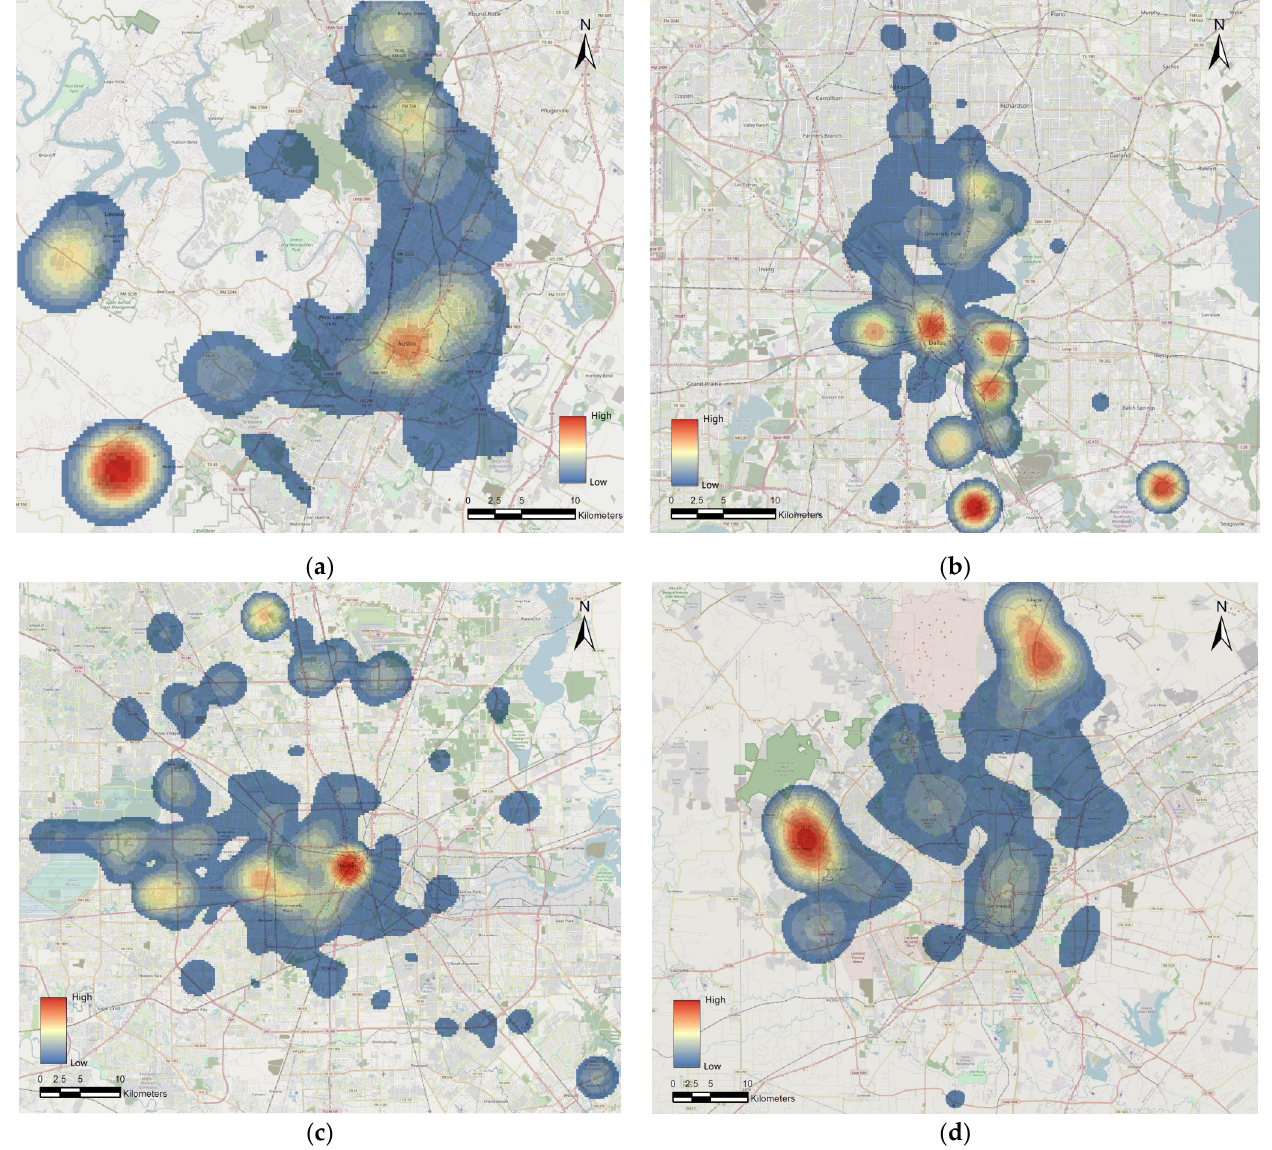
Figure 7. Spatial distribution density of green buildings in four major cities: ( a ) Austin, ( b ) Dallas, ( c ) Houston, and ( d ) San Antonio.